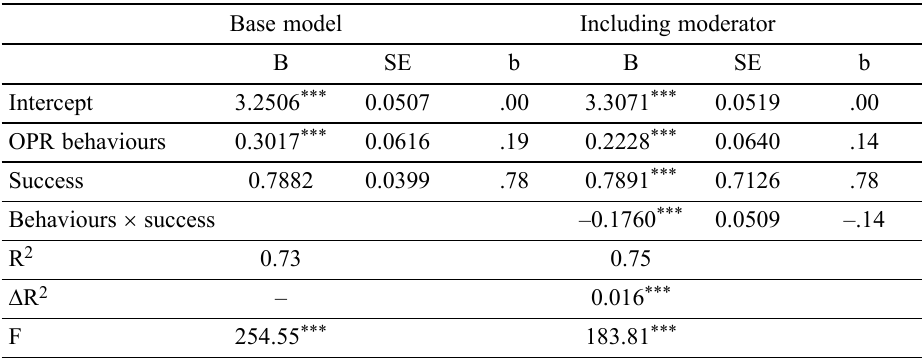
Table 2. Moderation effect of CE success on the relationship between frequency of opportunities recognised and opportunity recognition behaviours Base model Including moderator B